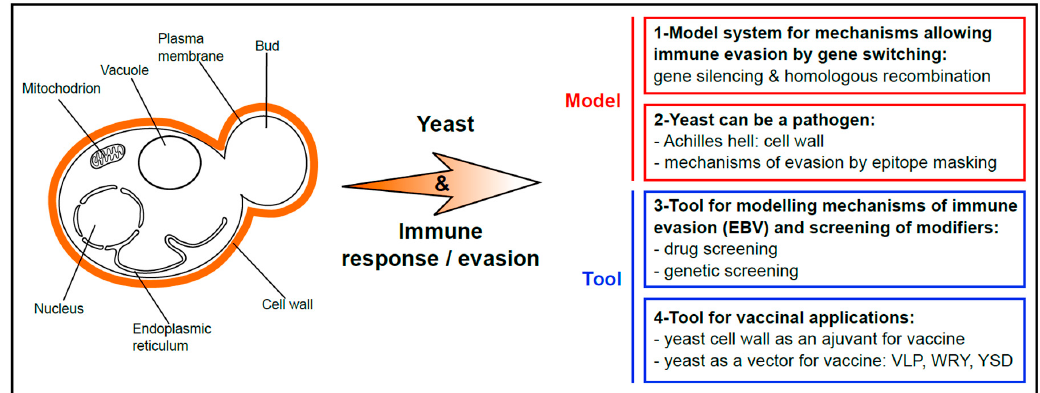
Figure 1. Scheme summarizing the various use of yeast to explore and modulate immune response and immune evasion. Yeasts are fungi and, as such, possess a cell wall that surrounds their plasma membrane, in addition to the typical features of eukaryotic cells (that include existence of a nucleus, mitochondria, vacuoles which are hydrolytic organelles similar to the lysosomes in higher eukaryotes, endoplasmic reticulum etc.). 1. Yeast is a model system for mechanisms based on gene repression and switching that allow immune evasion of many parasites. 2. Yeast can also be a pathogen, notably for humans and animals. Its cell wall is highly antigenic, and yeast has developed various mechanisms of epitope-masking to evade the host immune system. 3. Yeast is a tool for modelling the mechanism that allows immune evasion of the Epstein–Barr virus (EBV). This system has been successfully used to isolate drugs interfering with EBV stealthiness and to identify host cell factors involved in immune evasion of this oncovirus. 4. The antigenicity of the yeast cell wall has been biotechnologically exploited as an adjuvant for vaccination. In addition, yeast cells, heat-killed or alive, have been directly used as vectors for various antigens, hence combining the vaccine and the adjuvant in the same particle (VLP, virus-like particle; WRY, whole recombinant yeast; YSD, yeast surface display).